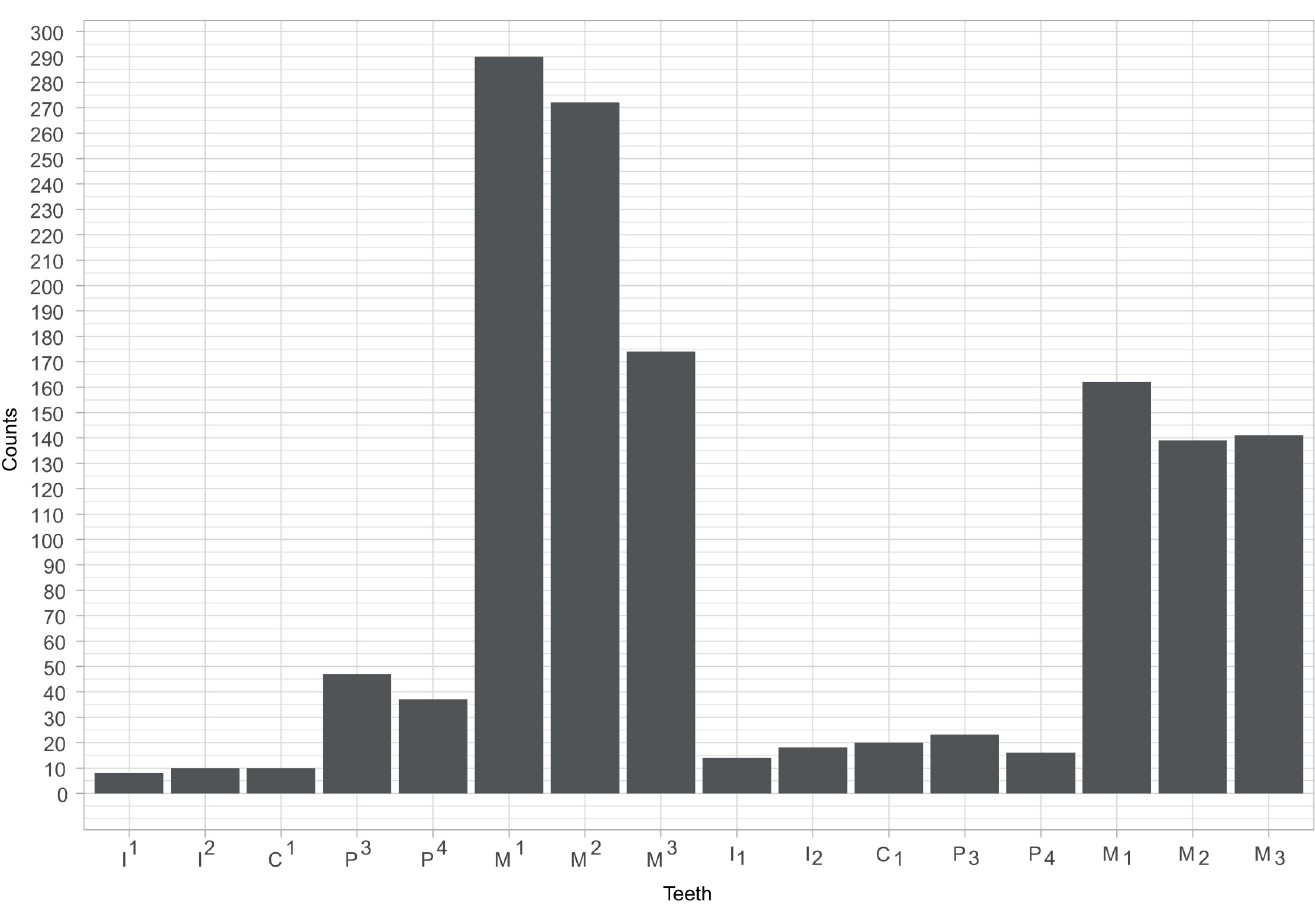
Fig 20. Number of phenotypes in individual teeth.